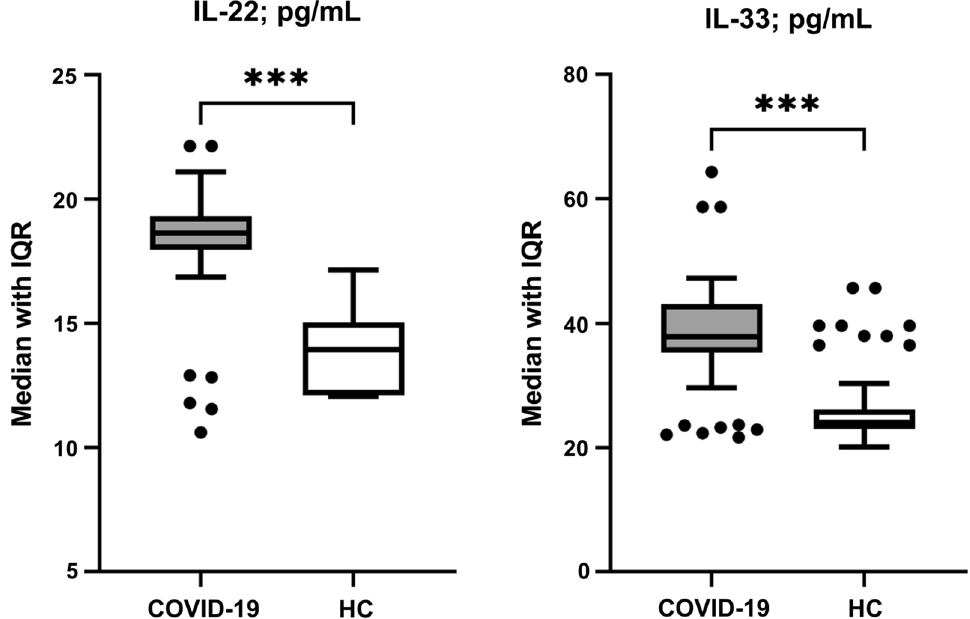
Fig. 2 Box and whisker plots (Tukey method) of serum concentrations of IL-22 and IL-33 in COVID-19 patients ( n n 90). Horizontal line inside box represents median. Whiskers represent interquartile range (IQR). Black circles represent outliers. Significant = difference was assessed using Mann–Whitney U test (*** p < 0.001). Median IL-22 and IL-33 concentrations were significantly elevated in COVID-19